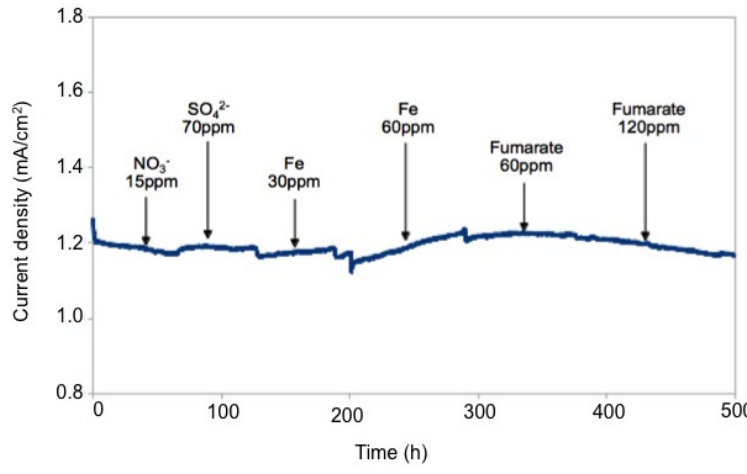
Figure 3. Soluble electron acceptor test on MEC operation behaviour.